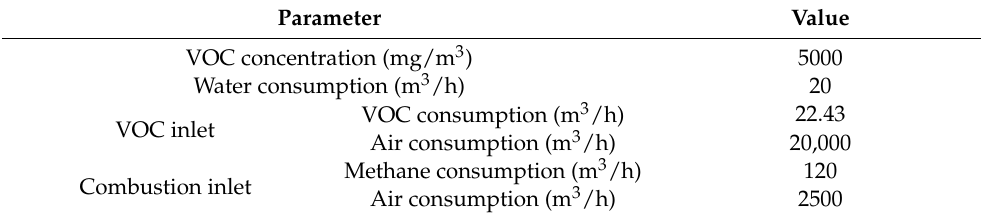
Table 2. Heat exchanger temperature